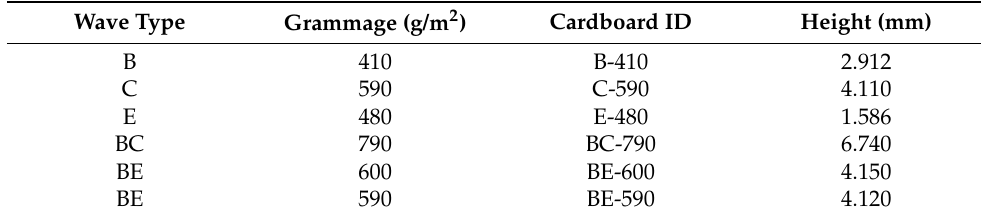
Table 2. Basic parameters of